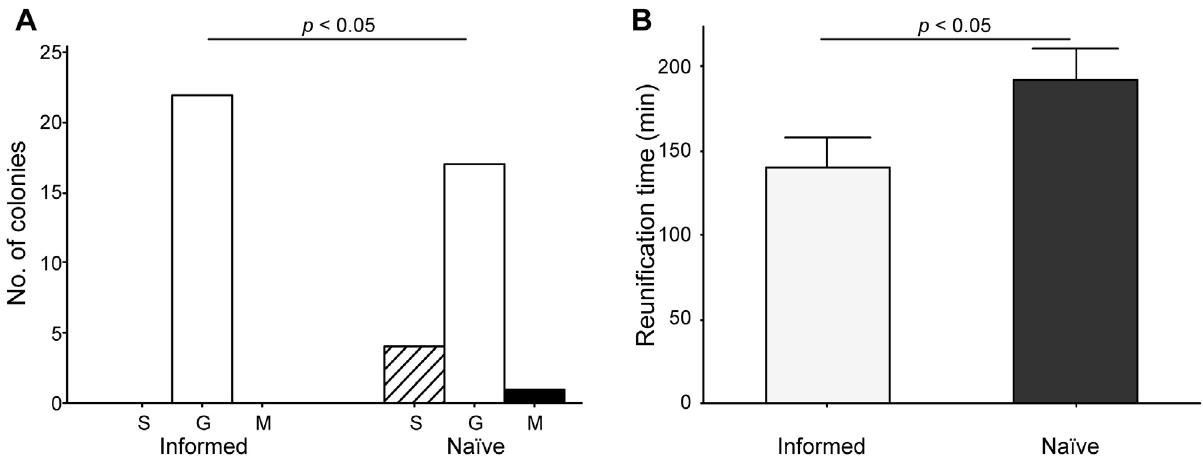
Figure 5. Prior experience and speed-accuracy trade-off (experiment 3), final state. ( A ) Number of colonies split (S, hashed bars) or having chosen the good (G, white bars) or mediocre nest (M, black bars) 24 hours after emigration onset. Nest choice patterns were compared between treatments using Fisher-Freeman-Halton’s exact test and nest preference was tested within each treatment using exact binomial tests (ns: non- significant; ****: p , 0.001). ( B ) Reunification time for informed (light grey, n=18) and naı¨ve (dark grey, n=18) colonies. Bars and whiskers represent the means and standard errors, respectively. The effect of treatment on reunification time was tested using GLMM (no data transformation).